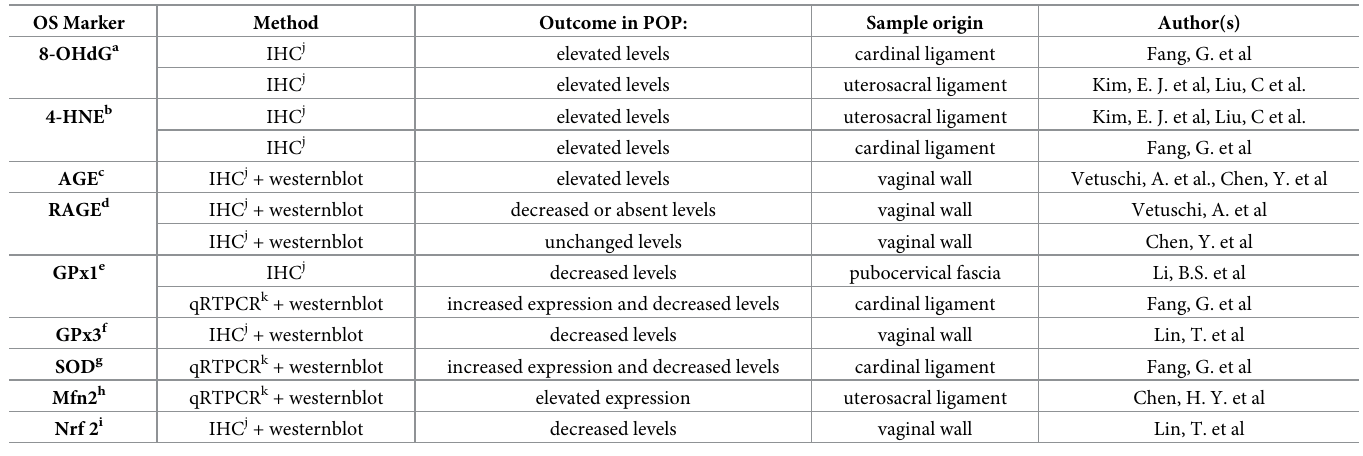
Table 2. Markers of oxidative stress in pelvic organ prolapse